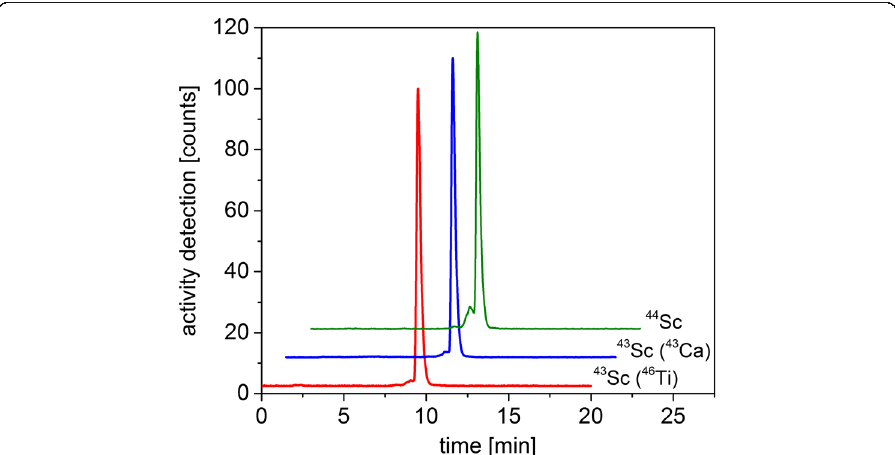
Fig. 5 HPLC chromatograms of 43 Sc isolated from 46 Ti and 43 CaCO 3 target material and 44 Sc, directly after the radiolabeling reaction with DOTANOC (the chromatograms of 43 Sc- ( 43 Ca) and 44 Sc-DOTANOC are shifted up and sideways for better visibility). The retention times of free 43 Sc and 44 Sc were determined to be 2.2 ± 0.2 min and 9.7 ± 0.3 min for 43 Sc/ 44